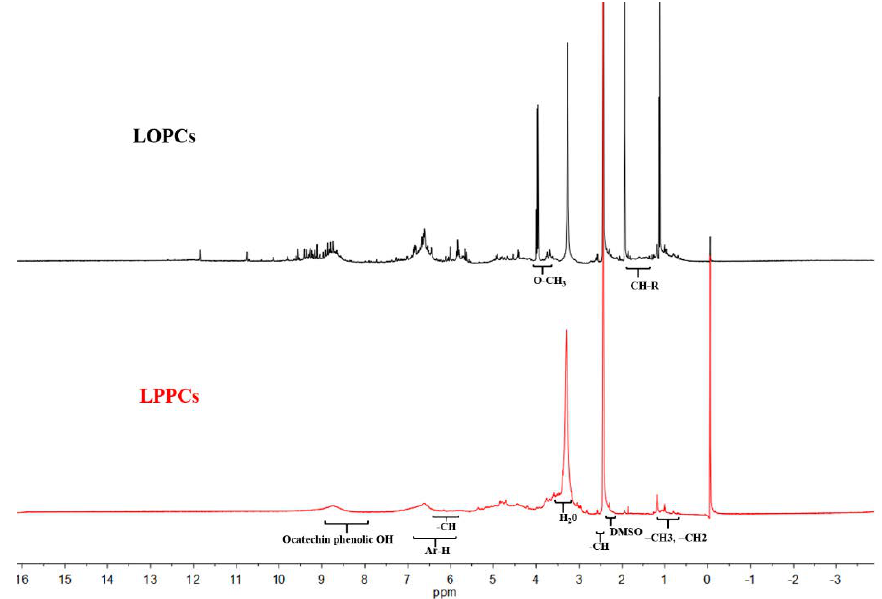
Figure 2. 1 H NMR spectra of larch polymeric proanthocyanidins (LPPCs) and larch oligomeric proanthocyanidins (LOPCs).